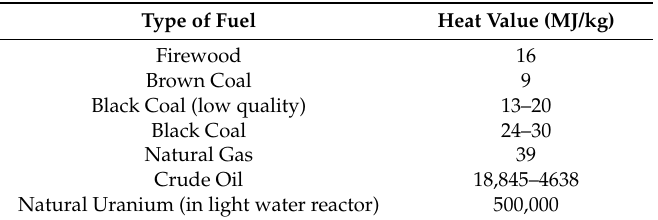
Table 2. Different sources of power and their heat value